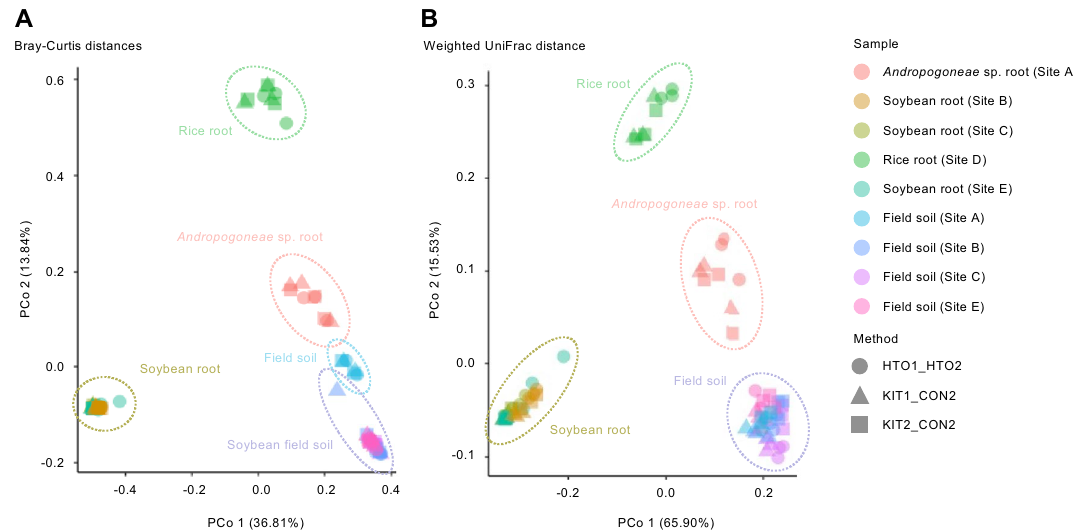
Figure 5. Plant root and soil microbial community diversity among new method and commonly used kits. Principal coordinate analysis based on Bray–Curtis distances ( A ) and weighted UniFrac distances ( B ). The circle with different biological samples. Cultivated or growing naturally plant roots and various types of soils were sampled from different geographical sites: Site A, brown forest soil (36°N, 140°E); Site B, gray lowland